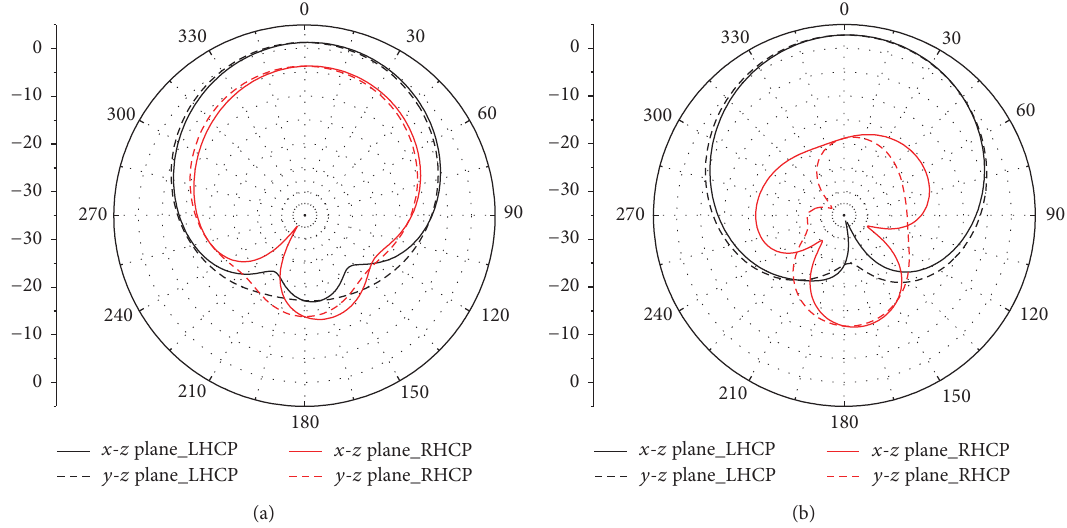
Figure 6: Radiation pattern of the antenna (a) without slot and (b) with slot.